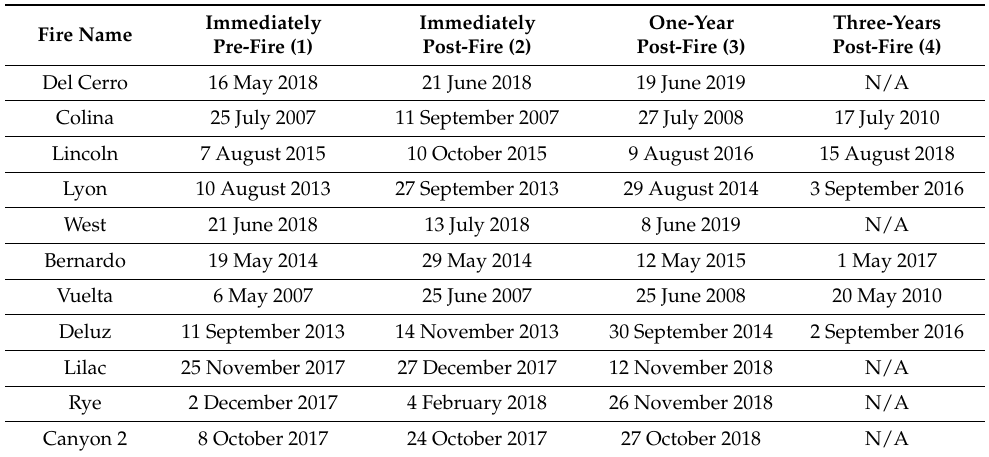
Table 2. Landsat imagery dates for each time-point condition for each